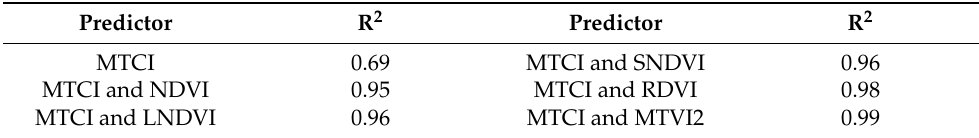
Table 7. Model evaluation for random forest